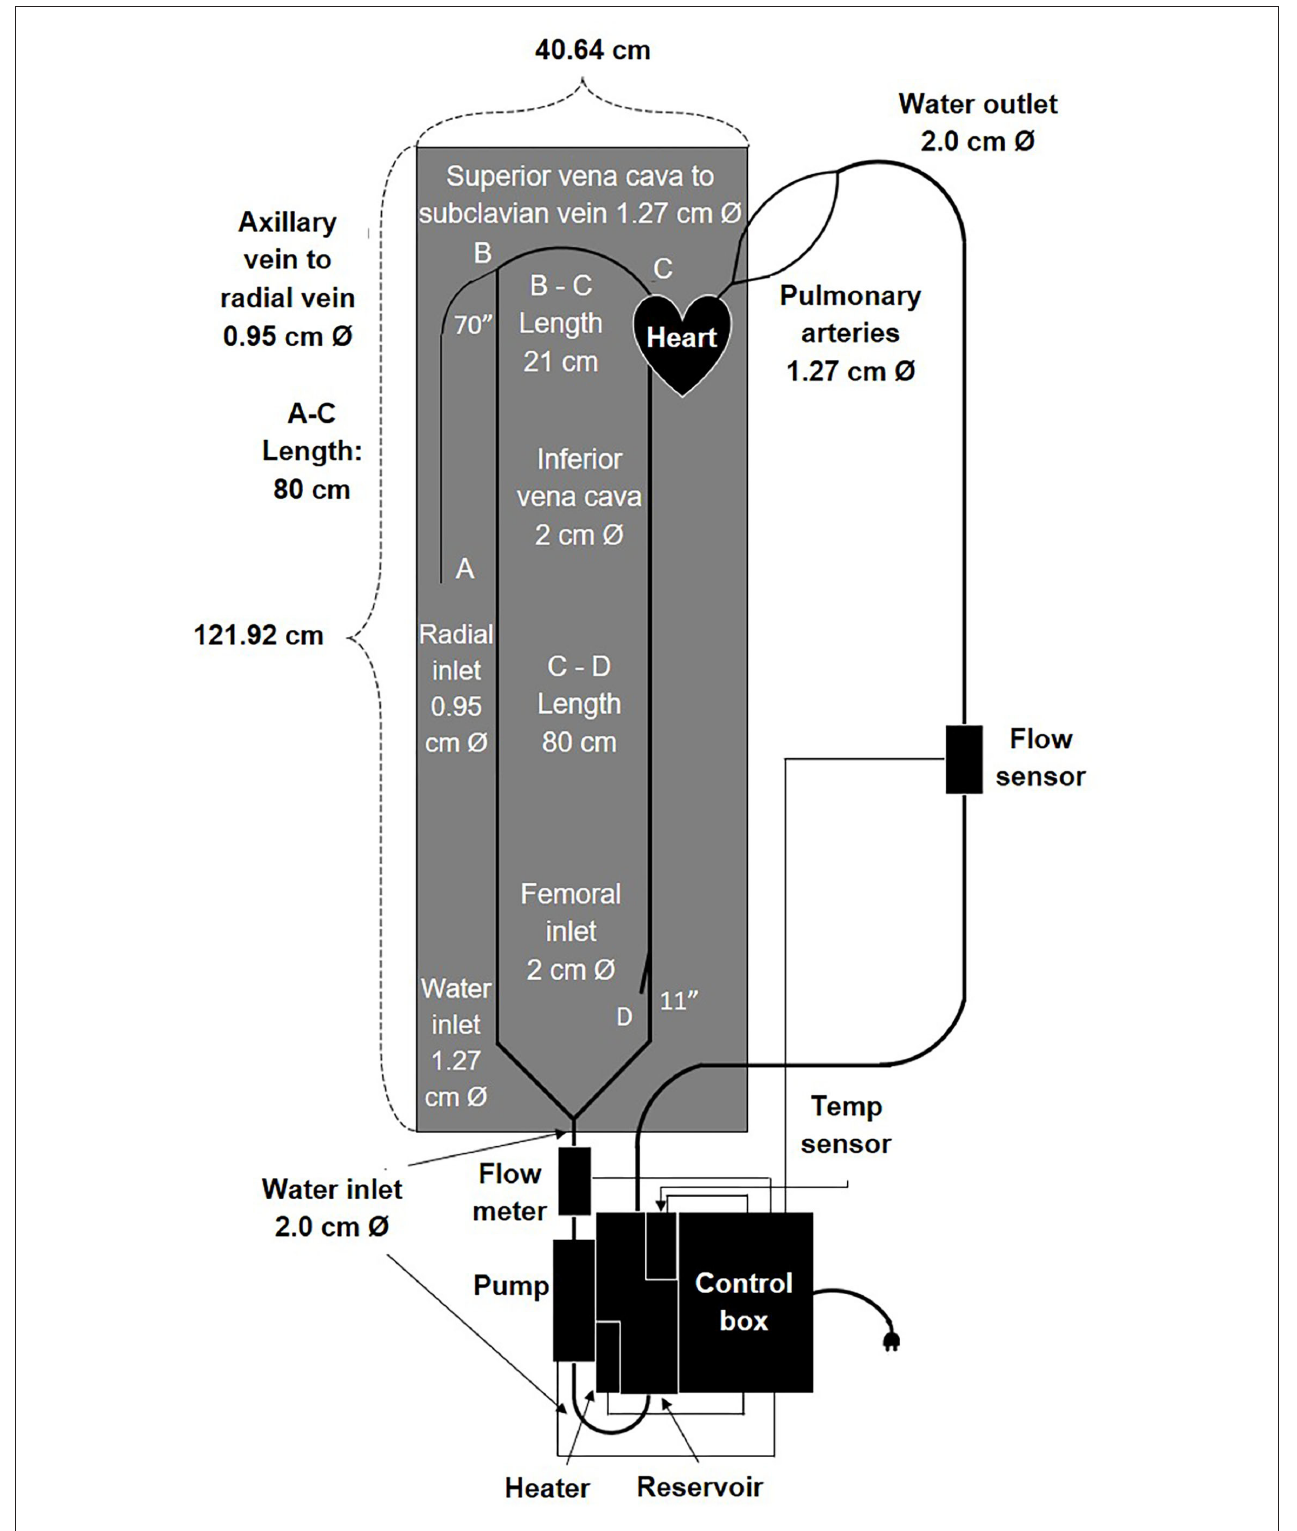
FIGURE 2 | Schematic drawing including components and dimensions of the cardiovascular flow simulator.